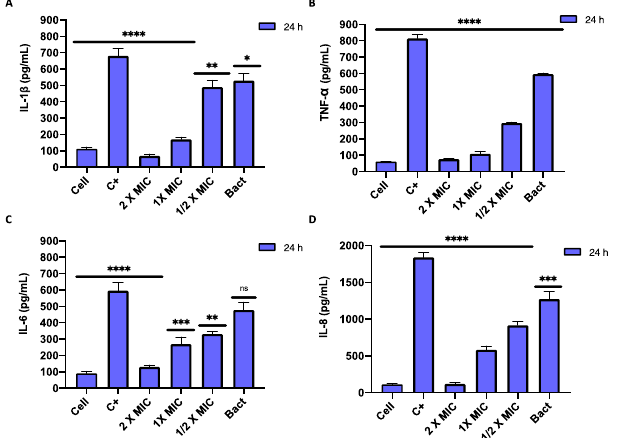
Figure 8. Effects of Arctostaphylos uva-ursi leaf extract on pro-inflammatory cytokine production in C. acnes -stimulated HaCaT cells. Cells were co-incubated with the compound at 1.2, 0.6 and 0.3 mg/mL and heat-killed C. acnes, for 24 h . The cells treated with LPS (10 μg/mL) represent the CTRL+ while untreated cells and cells treated with heat-killed C. acnes represent anti-inflammatory (Cell) and pro-inflammatory (Bact) control. The culture supernatants were subsequently isolated and an-